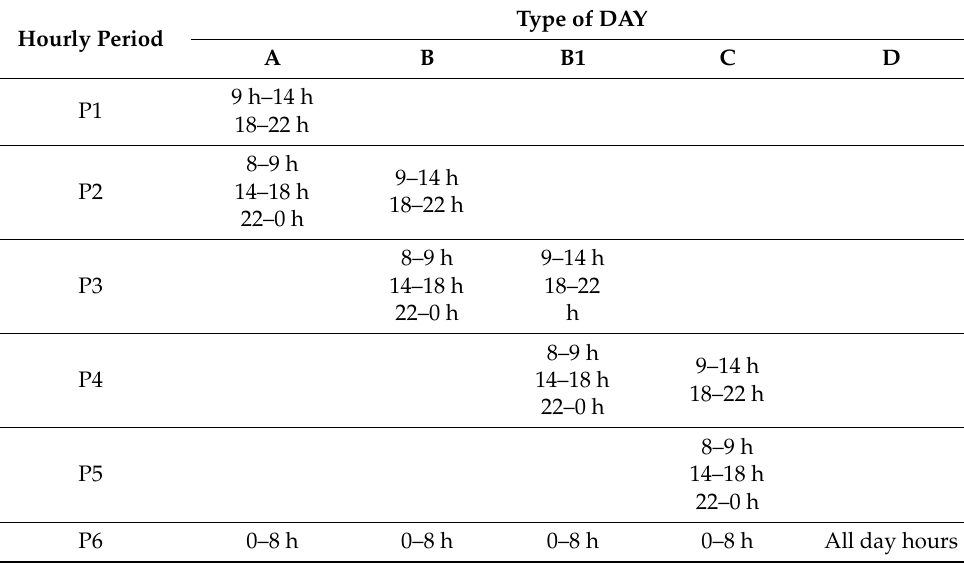
Table 3. Hourly billing periods according to the type of